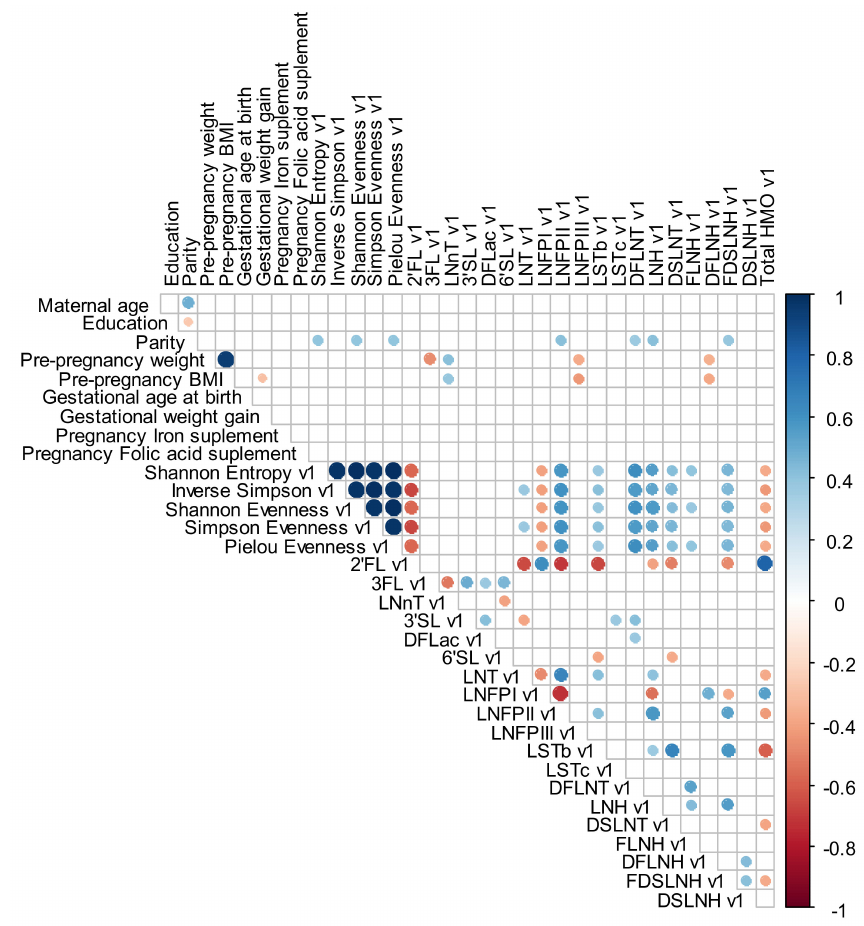
Figure 4. Spearman rank correlations between maternal demographic, anthropometric, reproductive and supplementary variables and individual HMO concentration in mmol / L and diversity and evenness at 2–8 days. The circle only becomes visible for the correlations that present a level of significance ≤ 0.01. The blue color indicates a positive and the red color a negative correlation. BMI: body mass index; DFLac, difucosyllactose; DFLNH, difucosyllacto-N-hexaose; DFLNT, difucosyllacto-N-tetrose; DSLNH, disialyllacto-N-hexaose; DSLNT, disialyllacto-N-tetraose; FDSLNH, fucodisialyllacto-N-hexaose; FLNH, fucosyllacto-N-hexaose; HMO, human milk oligosaccharide; LNFP, lacto-N-fucopentaose; LNH, lacto-N-hexaose; LNnT, lacto-N-neotetraose; LNT, lacto-N-tetrose; LSTb, sialyl-lacto-N-tetraose b; LSTc, sialyl-lacto-N-tetraose c; 2 (cid:48) FL, 2 (cid:48) -fucosyllactose; 3FL, 3-fucosyllactose; 3 (cid:48) SL, 3 (cid:48) -sialyllactose; 6 (cid:48) SL, 6 (cid:48)